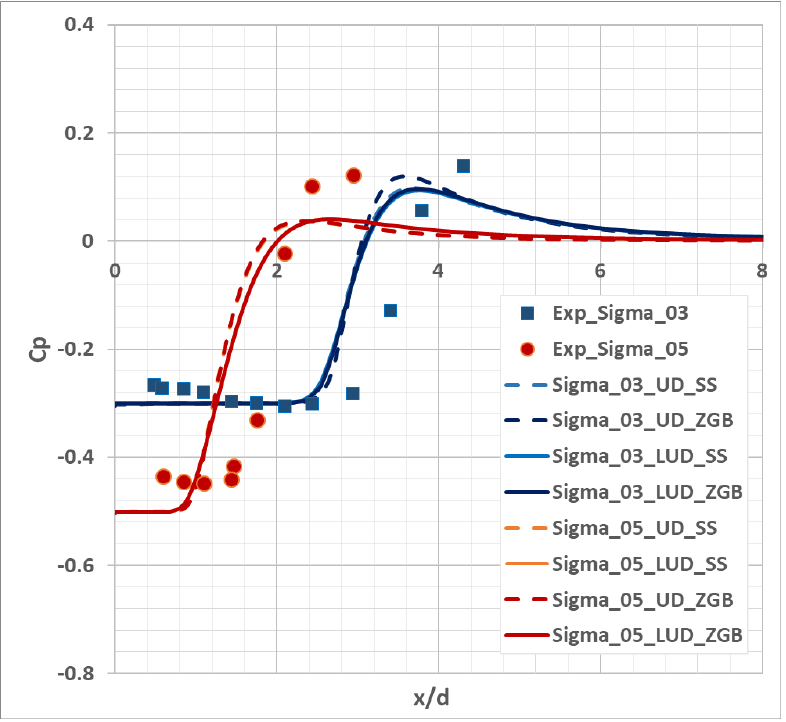
Figure 5. The pressure coefficient distribution over the length of the cylinder with plane end.